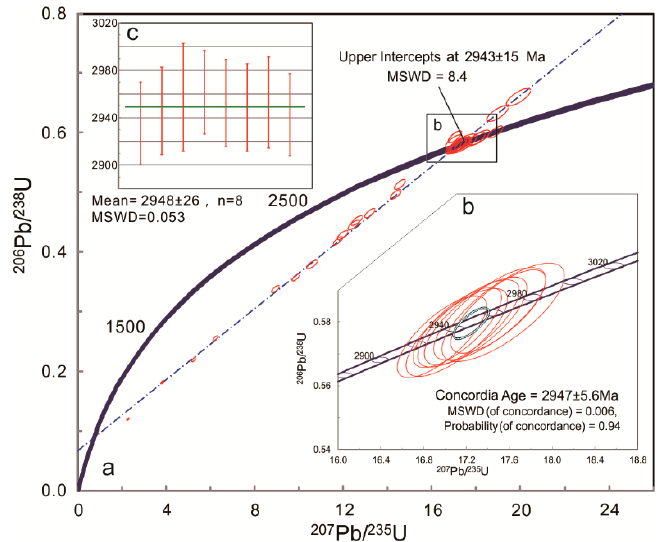
Figure 7. Zircon U–Pb concordia age diagram for the tonalitic gneiss (D0002-2). ( a ) Diagram for all analytical spots that gave a discordia line with an upper intercept 207 Pb / 206 Pb age of 2943 ± 15 Ma; ( b , c ) Diagrams for eight analytical spots that gave a concordant 207 Pb / 206 Pb age of 2947 ± 5.6 Ma and a weighted mean 207 Pb / 206 Pb age of 2948 ± 26 Ma.